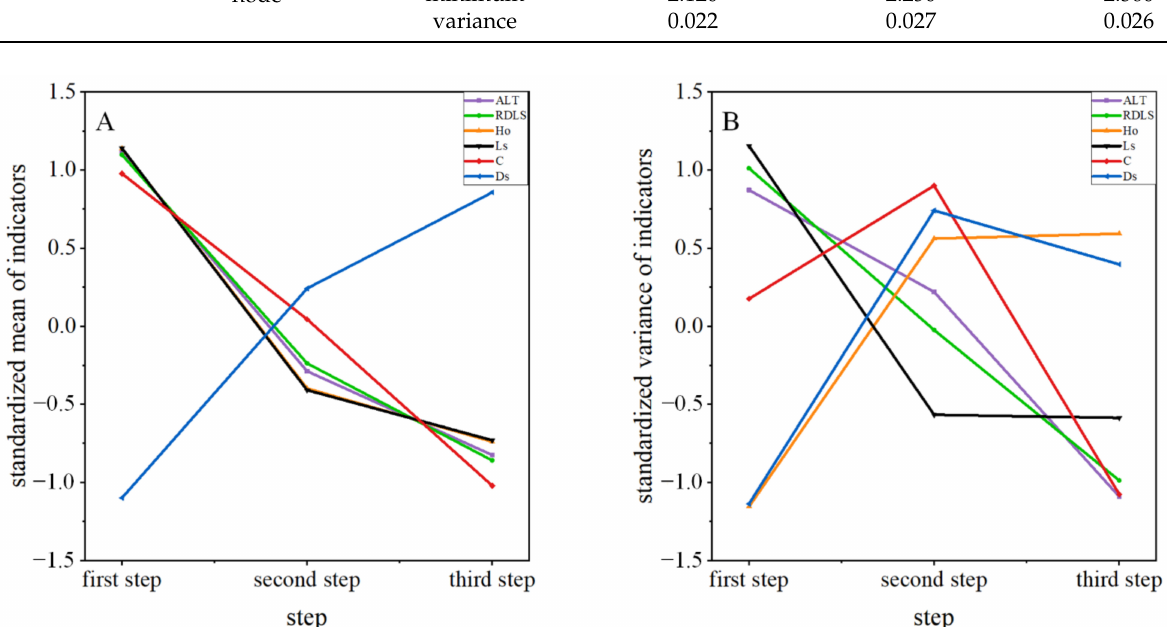
Figure 5. Comparison of index dispersions for the three steps of China’s terrain by using the standardized value. ( A ) Mean value. ( B ) Variance value. Note: ALT means average altitude, RDLS means relief degree of land surface, H o means street network orientation entropy, L s means average street length, C means average circuity, and D s means average streets per